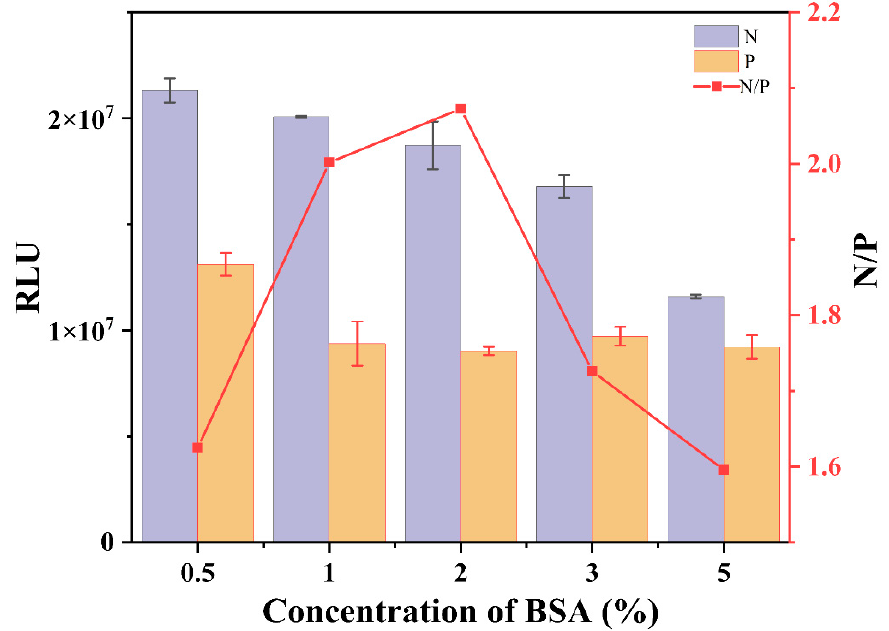
Figure 2. Effects of BSA on Cl-ELISA. The data are averages of three replicates. P: the RLU values of the positive wells (the concentration of IMI = 3.125 µ g/L), N: the RLU values of the negative wells (the concentration of IMI = 0).